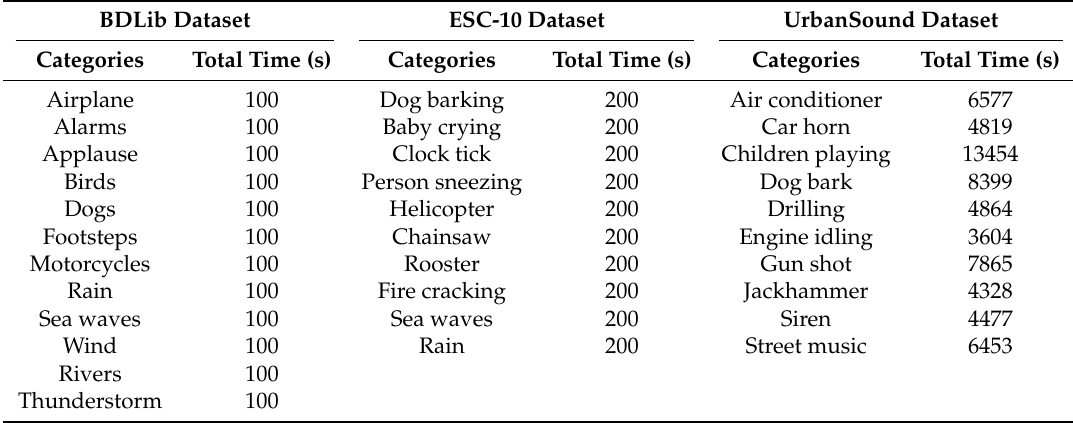
Table 1. Details of the most popular open source datasets for urban sound and